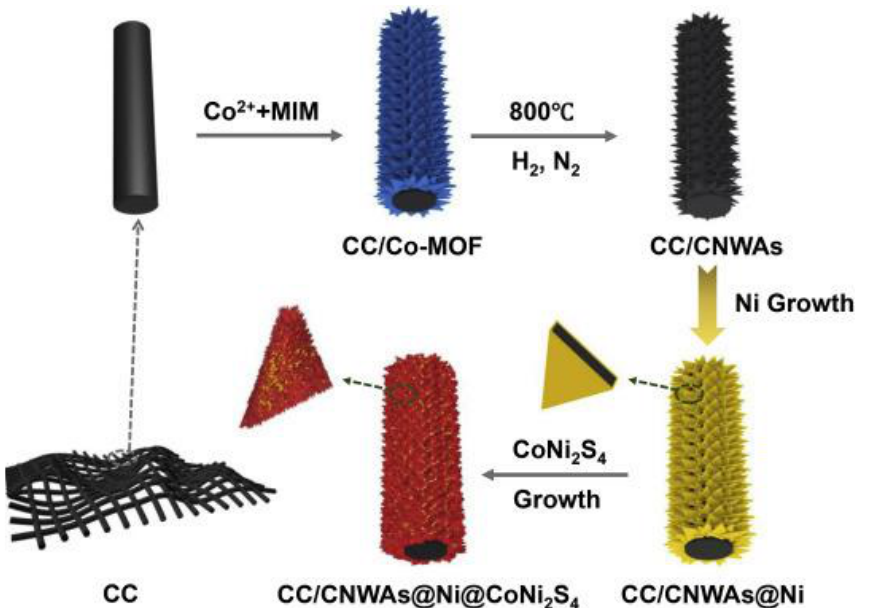
Figure 3. Schematic illustration of synthesis procedure for the hierarchical CC/CNWAs@Ni@CoNi 2 S 4 nanosheet arrays electrode [44]. Copyright 2019 Elsevier.